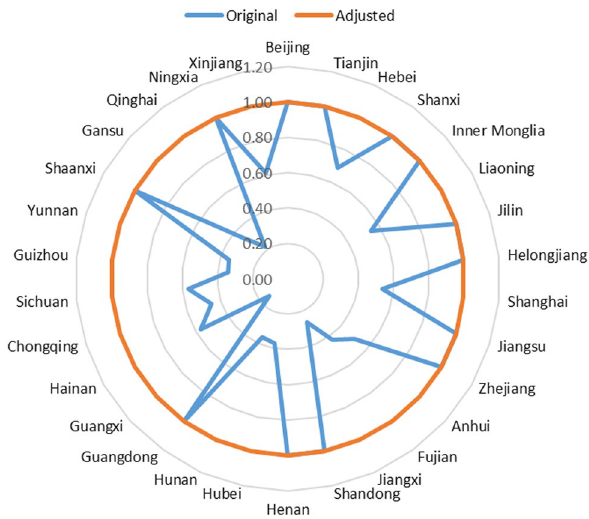
Fig. 6 Initial water resource efficiency in different provinces Fig. 7 Changes in the water resources share of each